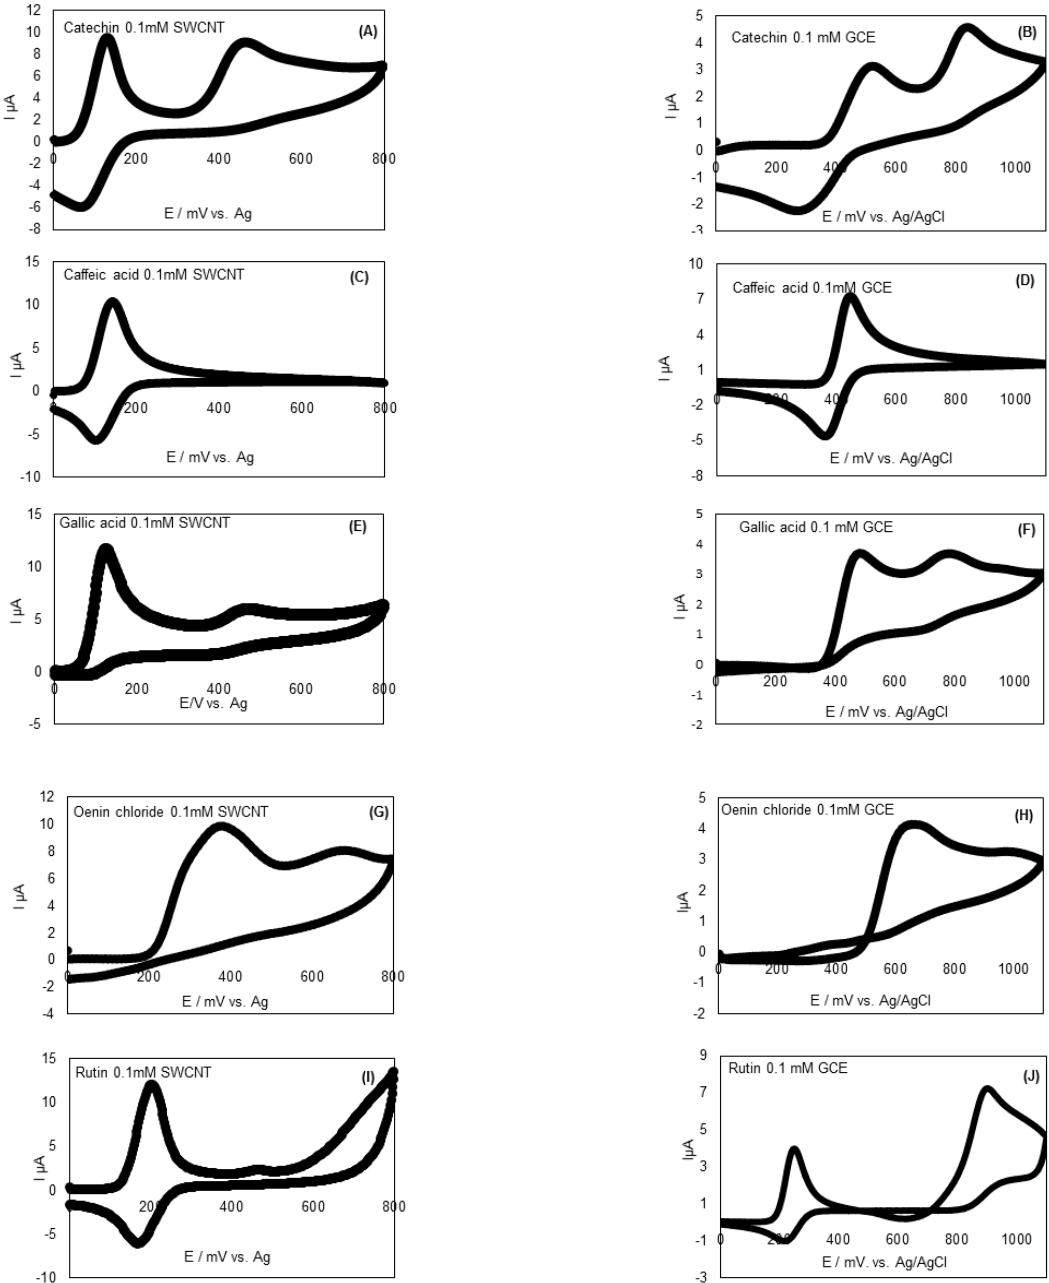
Figure 1. Cyclic voltammograms of catechin with SWCNT ( A ) and GCE ( B ), caffeic acid with SWCNT ( C ) and GCE ( D ), gallic acid with SWCNT ( E ) and GCE ( F ), oenin chloride with SWCNT( G ) and GCE ( H ), rutin with SWCNT ( I ) and with GCE ( J ) at a concentration of 0.1 mM (blank subtracted). GCE: Glassy Carbon Electrode; SWCNT-SPCE: Single Walled Carbon Nanotubes modified Screen Printed Carbon Electrodes.